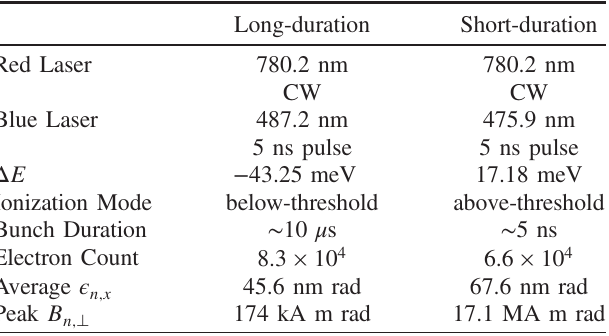
TABLE I. Laser parameters involved in the creation of the bunches and bunch characteristics for the long- and short- duration bunches shown in Fig. 2. The electron count is estimated from the streaked measurements which detected a total of 3 . 6 × 10 3 and 2 . 4 × 10 3 electrons for the long- and short-duration bunches